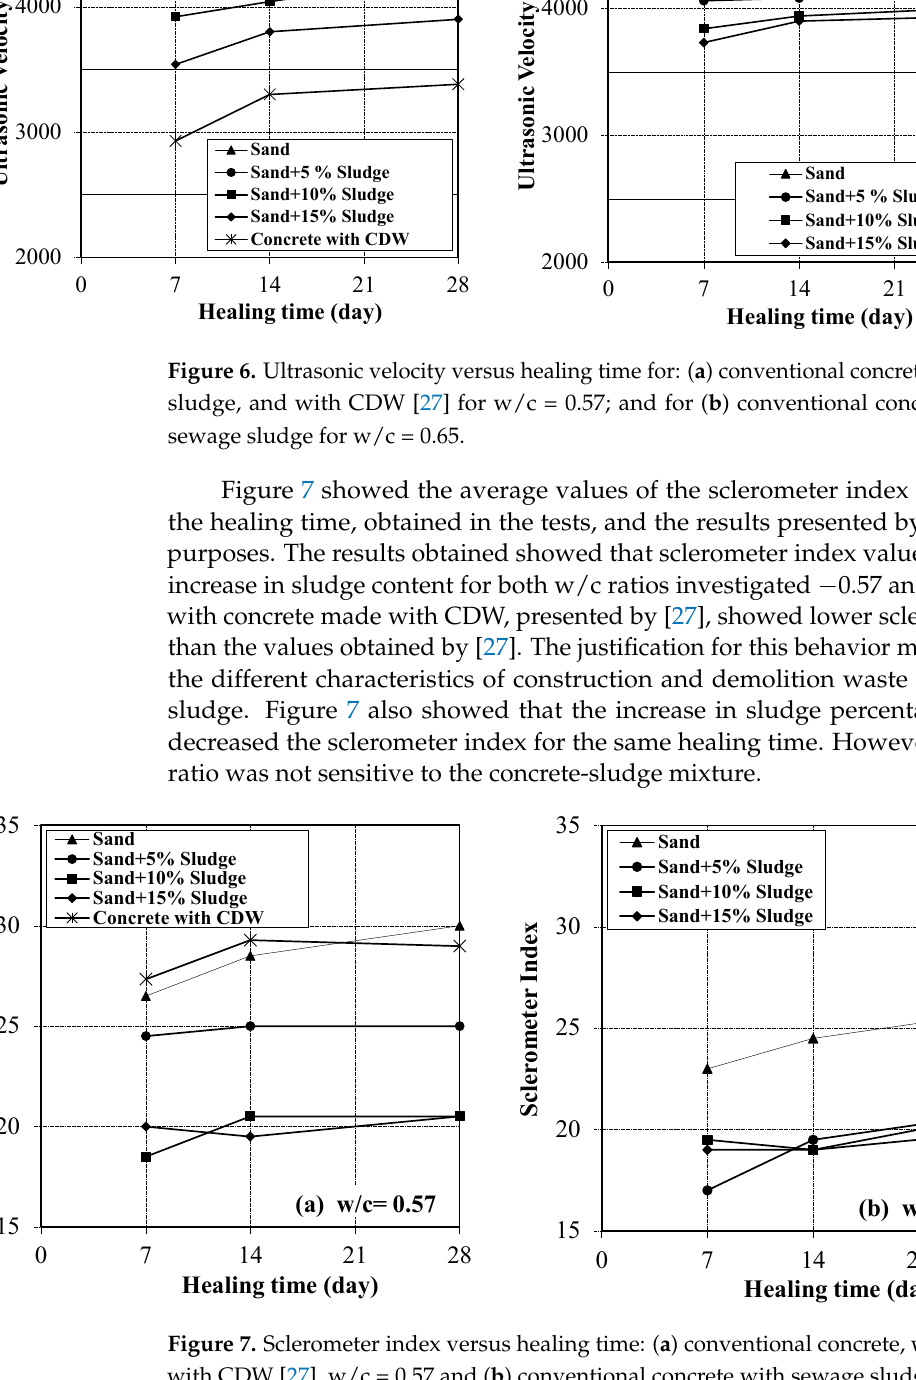
Figure 5. Particle size distribution of the aggregates.